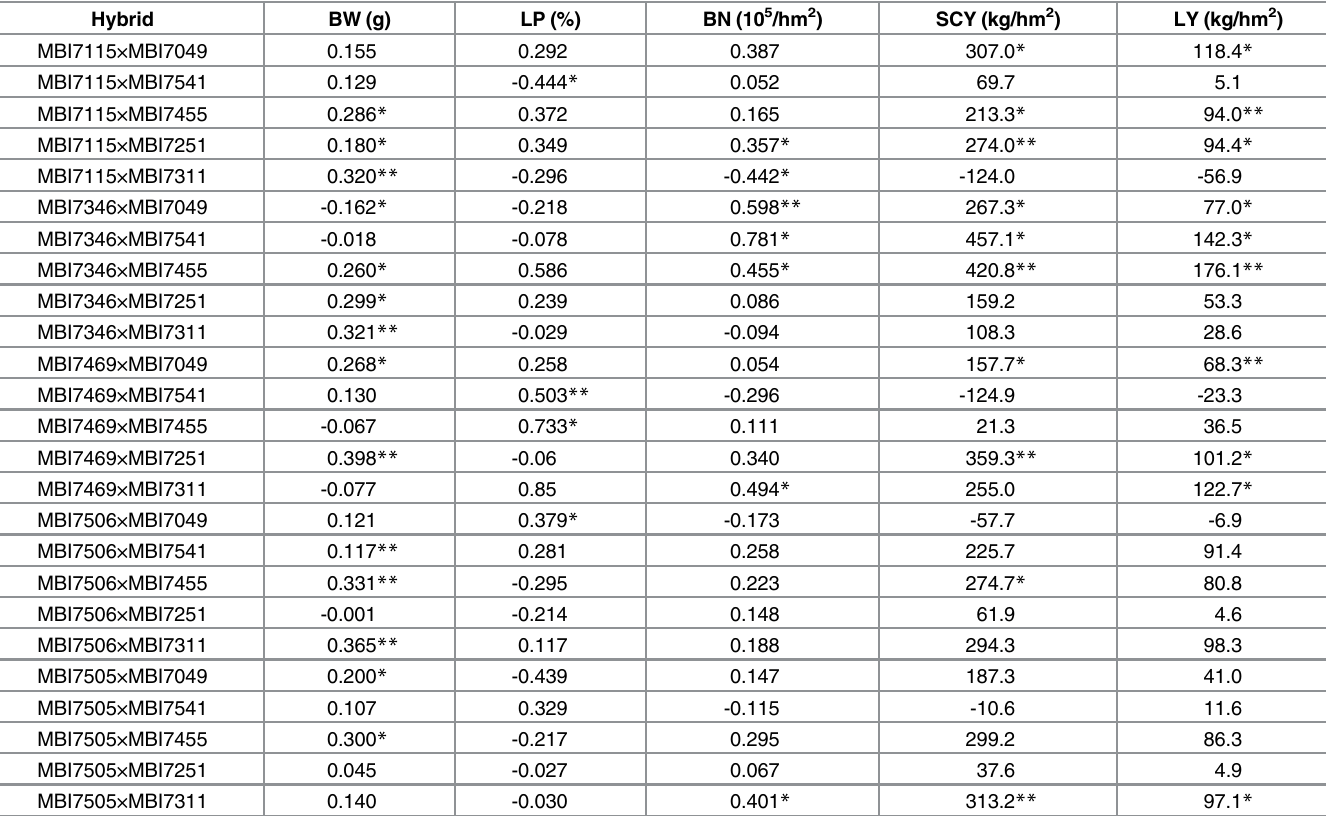
Table 5. Heterozygous dominance effects of F 1 for yield and yield components in PopCCRI45.